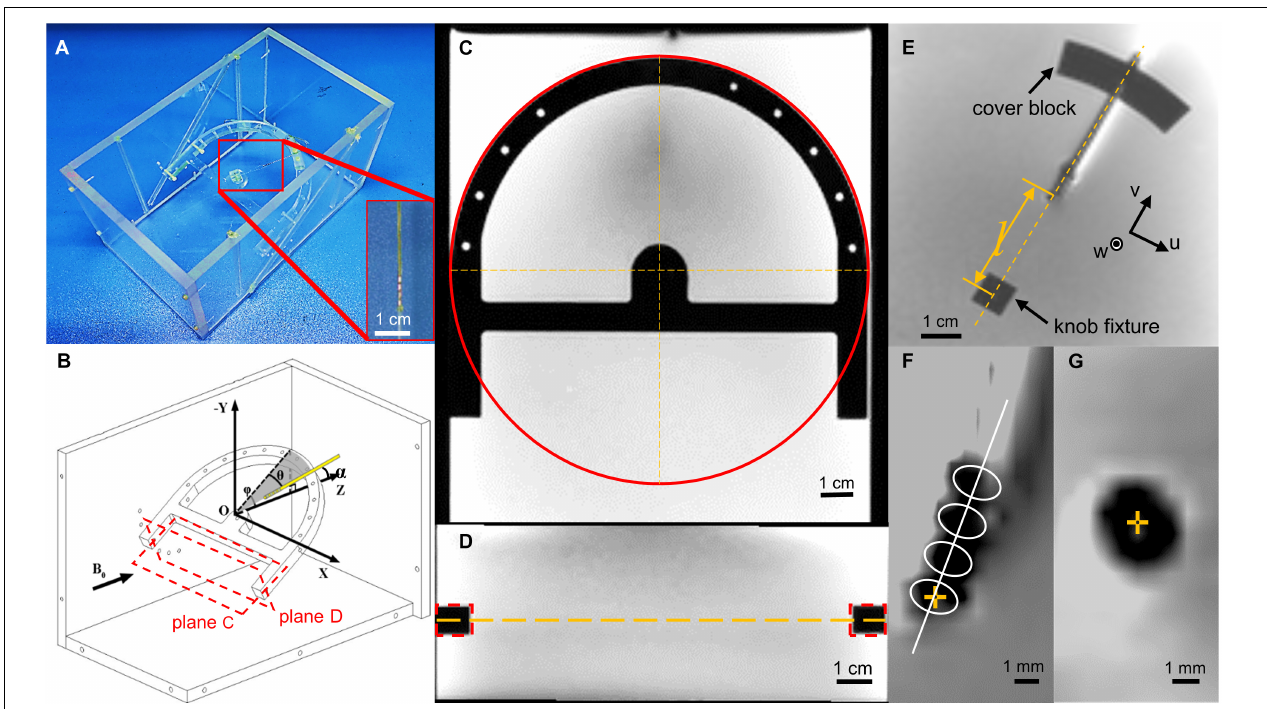
FIGURE 1 | Illustration of the experiment layout. (A) Photo of the phantom layout with the lead terminal tied to the nylon wire and fixed on a cubic fixture. (B) The schematic map of the experiment layout. Black vector stands for the direction of the main field. Plane (C,D) stands for the cross sections in (C,D) . (C) Demonstration of how we calculate the fixture coordinate system center in a slice and axis direction. The red circle stands for the Hough transformation, which gives us the coordinate of the fixture center. (D) Demonstration of how we calculate the slice that contains the coordinate system center. There d-dotted rectangle stands for the cross section of the fixture, which gives the center slice position, which contains the lead. (E) Magnetic resonance (MR) image of the lead, cover block, and knob fixture, and depiction of the u and v axes, whereas the w-axis is perpendicular to the u–v plane. Length l indicates the distance between contact 0 and the center of the knob fixture, measured using an image measuring instrument. (F) The template used to directly identify the contact center in the coronal view. The center of contact 0 is highlighted with a yellow cross mark. (G) The contact center is in transverse view, highlighted with a yellow